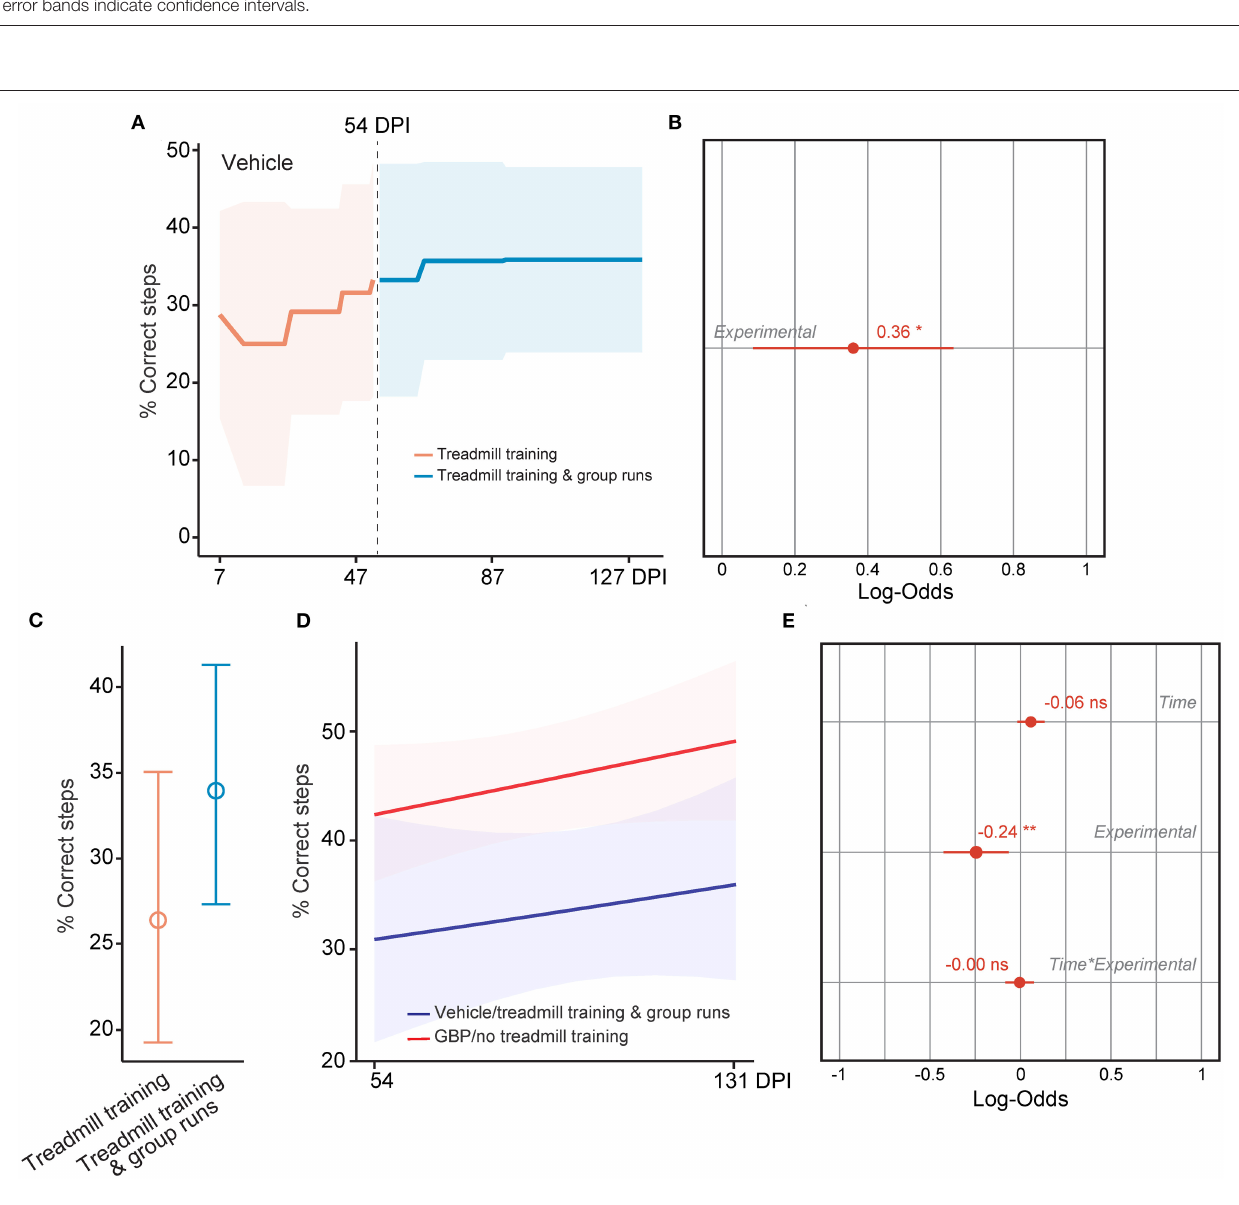
FIGURE 8 | motivation in mice administered GBP was measured after addition of a social motivator (e.g., group runs) into the treadmill training starting at 54 DPI. Mean and standard deviation (GBP with treadmill training n = 14). (E) Analysis of (D) . Variable effects on motivation toward rehabilitative treadmill training in SCI mice administered GBP are displayed as coefficients with confidence intervals (Generalized linear mixed effect model for repeated measures * p < 0.05, ** p < 0.01, ns not significant, GBP with treadmill training n = 14). (F) Predicted changes in motivation toward the rehabilitative treadmill training in SCI mice administered GBP. Shaded error bands indicate confidence intervals.